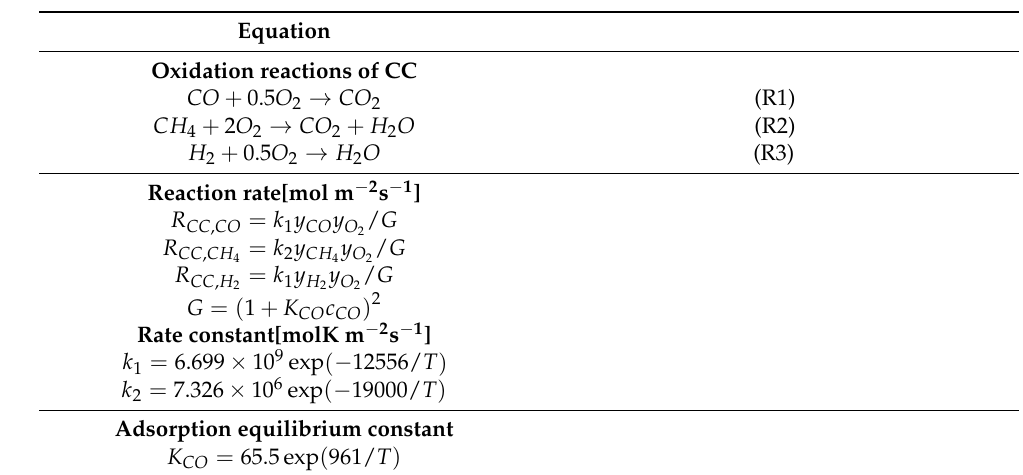
Table 8. Equations for the reaction rate of CC based on Ref.